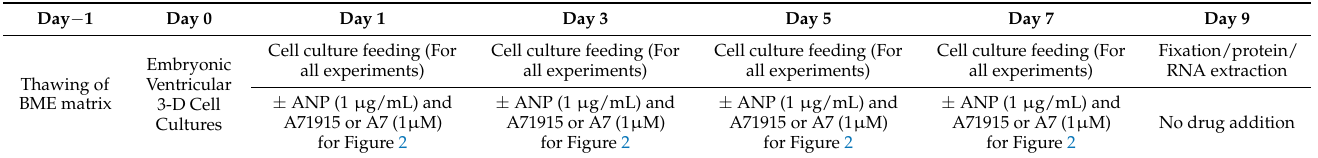
Table 1. A timeline chart showing the details of drug concentrations and timepoints for media and drug changes. ANP: Atrial Natriuretic Peptide, A71915 or A7 (Natriuretic peptide receptor A/NPRA inhibitor).